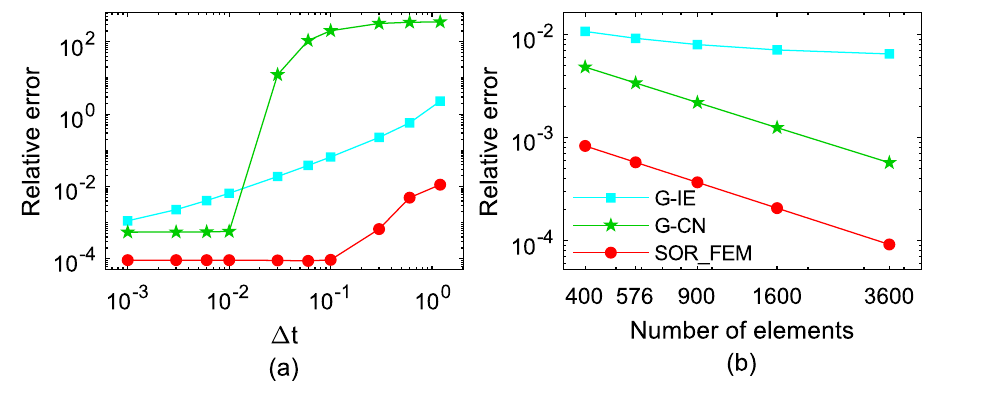
Figure 6. Relative error for different time-step and mesh refinements at time t =